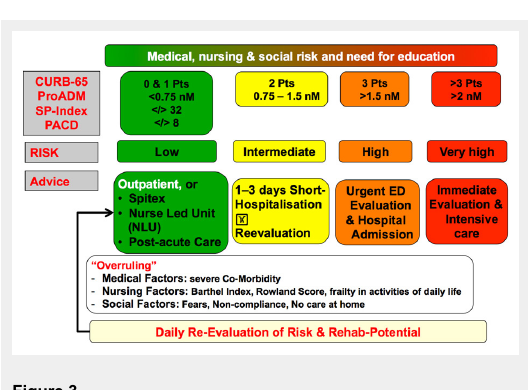
CURB-A score combining the traditional CURB-65 criteria with levels of proADM to risk stratify site-of-care decisions in patients with lower respiratory tract infections. ICU = intensive care unit; ProADM = pro-adrenomedullin; SP = Selbstpflege (self-care); PACD = post-acute care